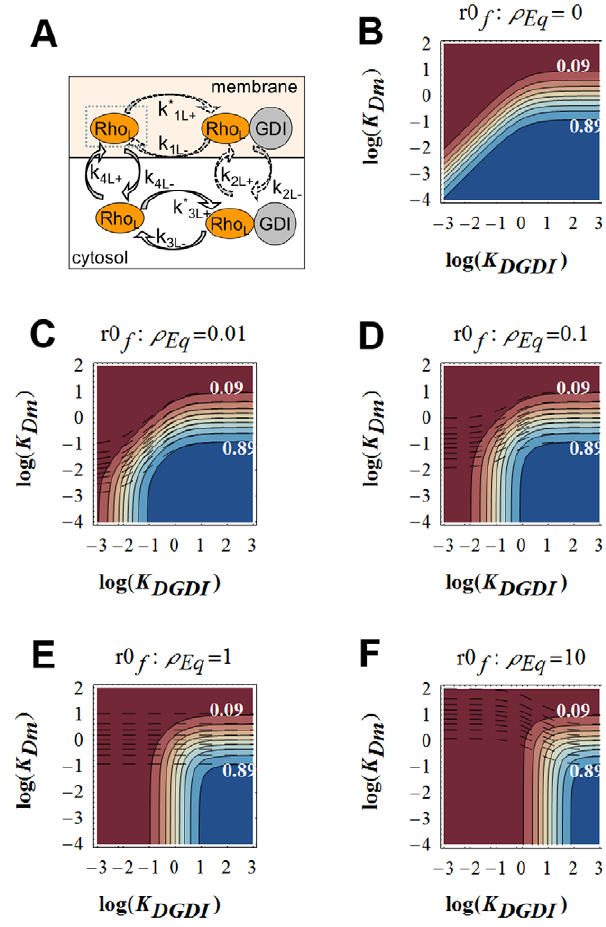
Figure 2. Model for analysis of fraction of GTPase at the membrane. A. Model for lumped variables and rates. The term in the dotted box includes effector bound GTPases. The dashed arrows represent the GDI mediated membrane cycling of GTPases. B–F. Fraction of GTPase at the membrane free from GDI as r Eq ranges from 0 to 10. The upper contour corresponds to 9% fraction at the membrane, while the lowest line represents 89%. Each pair of neighboring lines is 10% apart in membrane fraction. When r Eq =0, all membrane bound GTPase is free from GDI ( r0 = r0 f ). The total fraction of GTPase at the membrane r0 is represented by the dashed lines when r Eq . 0.